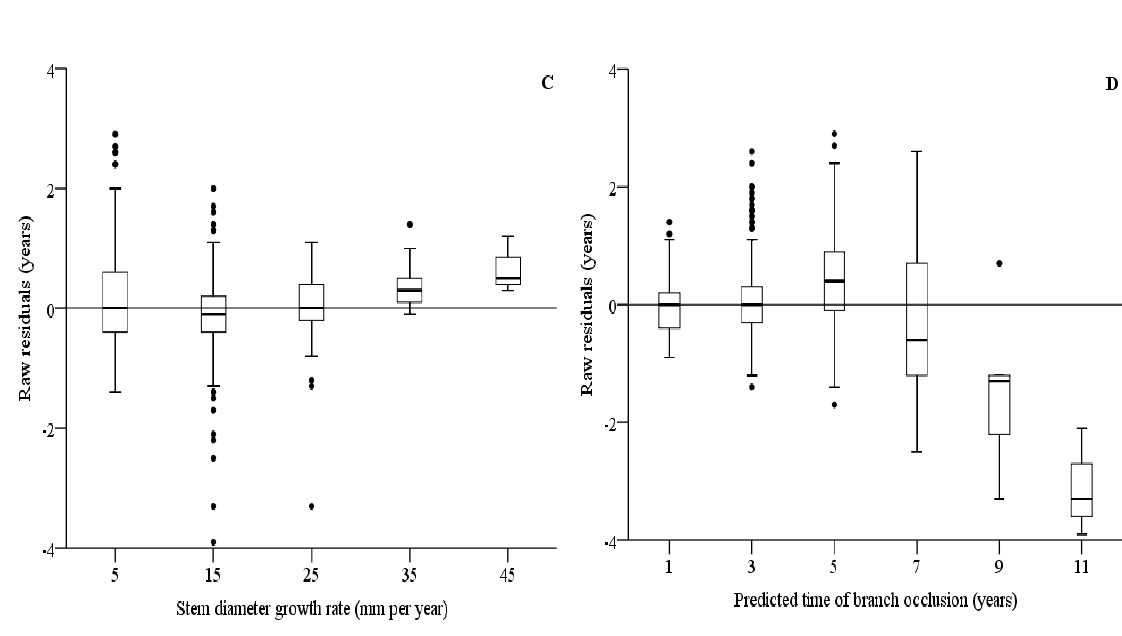
Figure 2. Raw residuals of the model for time of branch occlusion plotted against the independent variables ( A , B and C ) and predicted variables( D ). The edges of the box are 25th and 75th percentiles; the vertical lines are drawn from the box to the most extreme point within 1.5 interquartile ranges; the transverse lines in boxes connect the